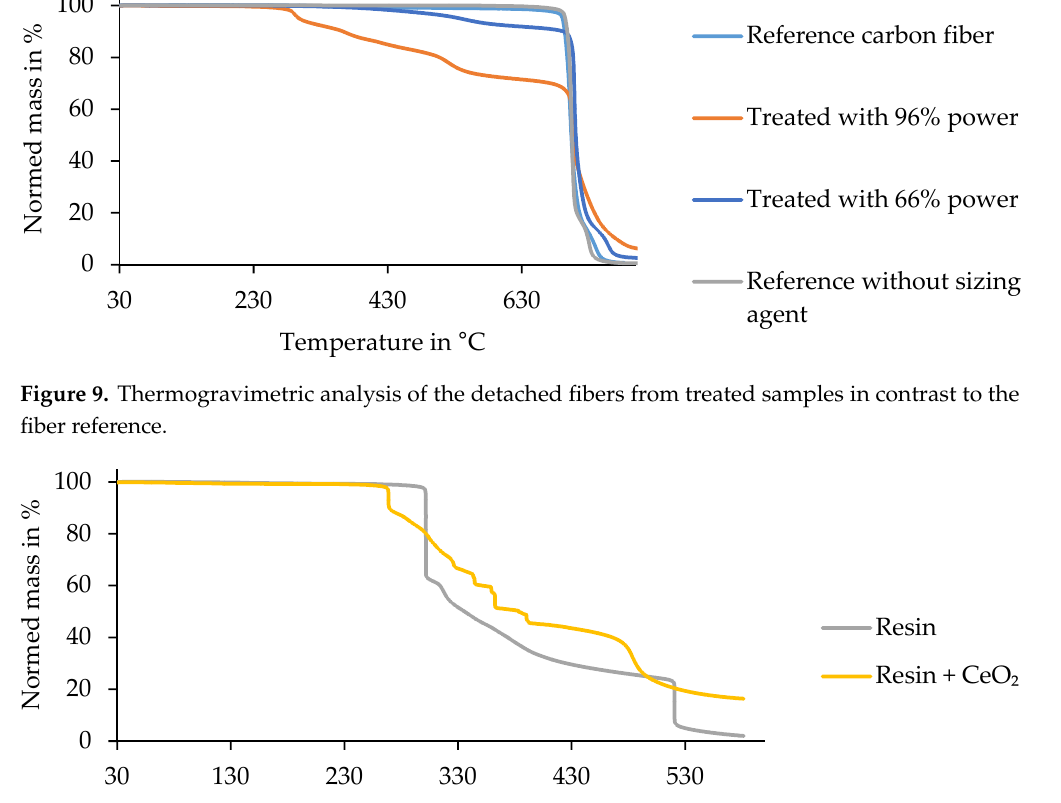
Figure 9. Thermogravimetric analysis of the detached fibers from treated samples in contrast to the fiber reference.